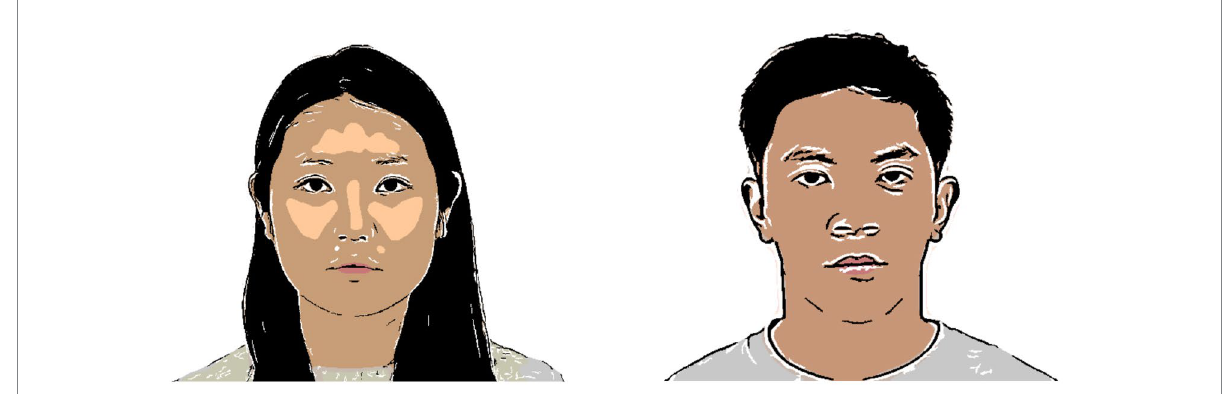
FIGURE 1 Examples of modified face images used in the studies. Adapted with permission from Chicago Face Database, available at https://www. chicagofaces.org/ (Ma et al.,